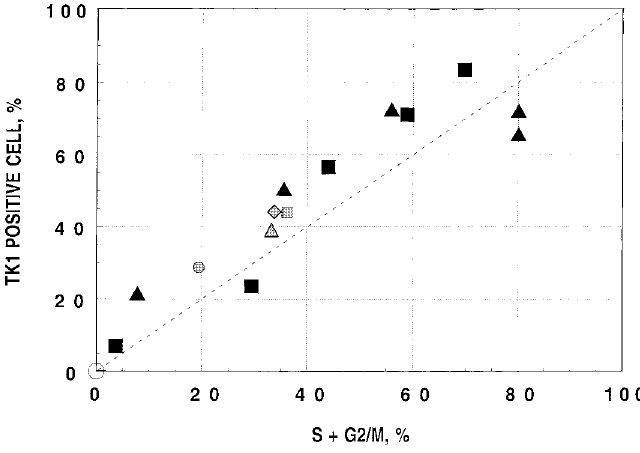
Fig. 2. The relationship between the percent of S+G2/M cells as measured by DNA flow cytometry and the cytologically TK1 positive cells. ( Q ) elutriated CEM cells, ( 2 ) elutriated Hela cells, ( ) non-separated CEM cells, ( ) non-separated Hela cells, ( ) non-separated EAT cells, ( ! ) unstimulated lymphocytes and ( ) stimulated lymphocytes. The ideal line of equal values is also